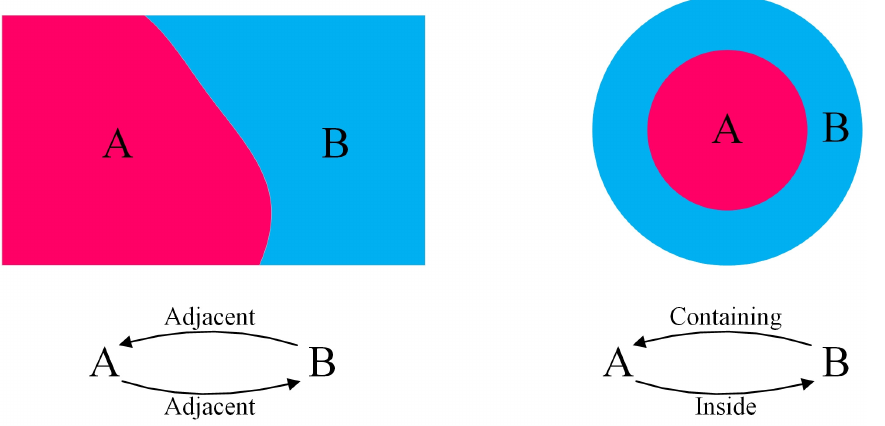
Figure 4. Diagram of the spatial relationships between neighboring objects. A and B represent different land covers. There are three types of relationships between objects: containing, inside, and adjacent. Table 1. Object features and their